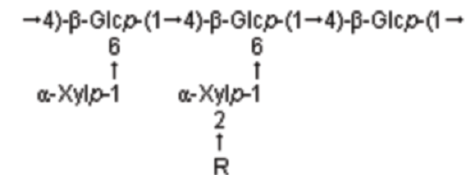
Figure 2. Schematic structure of tamarind seed xyloglucan. Glcp, D-glucopyranose; Xylp, D-xylopyranose; R: H or β -